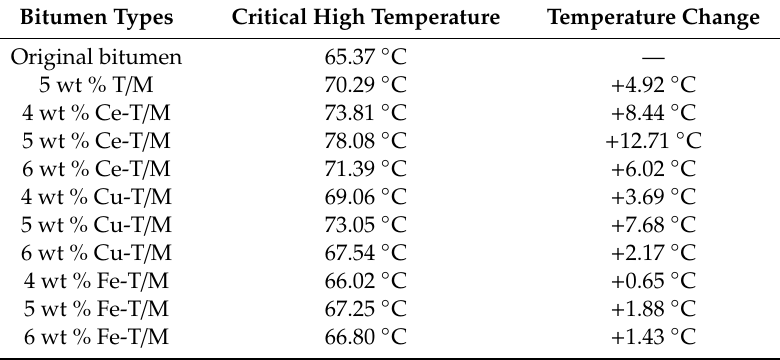
Figure 5. Variation of δ value of ( a ) Ce-T / M, ( b ) Cu-T / M, and ( c ) Fe-T / M modified bitumen at different temperatures. Table 3. Critical high temperature for different bitumen samples.